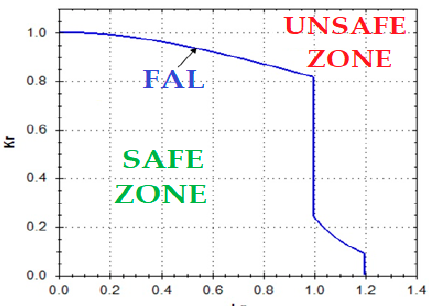
Figure 4. Failure assessment diagram (FAD) graphical representation.